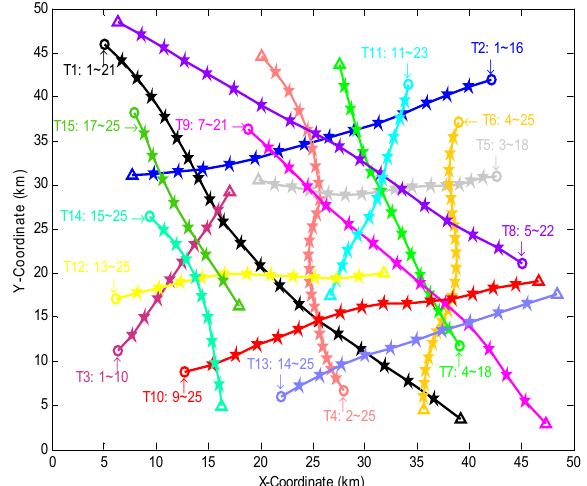
Figure 3. Target trajectories in a simulation. ○ , △ and ★ are the start point, end point and rest positions of a target, the solid line is the track of a target, different colors correspond to different targets. Figure 4a~f show the results of sensor selection at the 1st, 5th, 10th, 15th, 20th and 25th scans. It can be seen that the SNs selected by each LFC will change adaptively with the multi-target movement versus time. Specifically, in order to minimize the bound in Theorem 1, most of the selected SNs locate in the regions closer to the survival targets at each scan. A few SNs which are far from the survival targets are selected to satisfy Constraint C2 . Moreover, due to Constraint C3 , the homogeneous SNs of each LFC cannot be excessively concentrated in a small region.